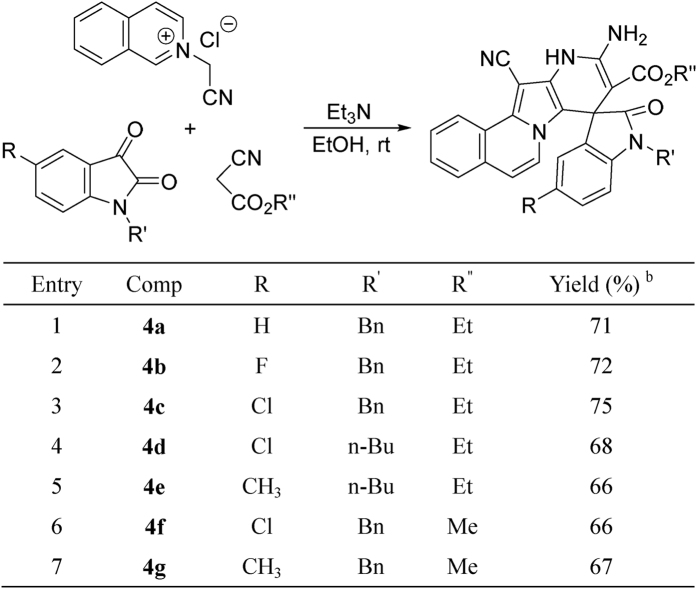
Synthesis of spiro[indoline-3,8′-pyrido[2′,3′:4,5]pyrrolo[2,1-a]isoquinolines] 4a-4ga.